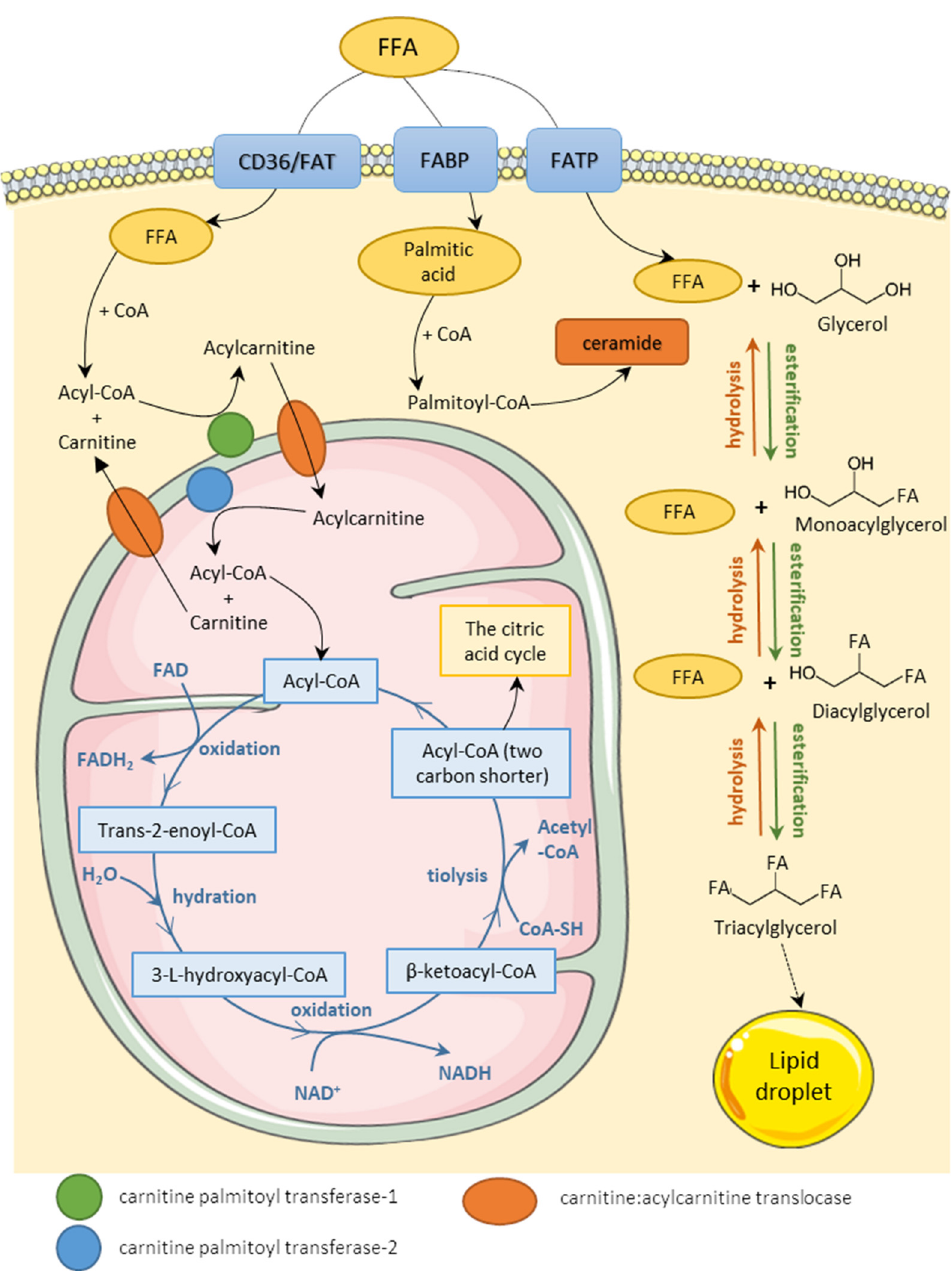
Figure 1. Homeostasis and metabolism of free fatty acids. FFAs circulating in the blood serum are bound to albumin. After the release from the albumin complex, FFAs are transported through the cell membrane by three various transporters: CD36/FAT, FABP, or FATP. Once in the cytoplasm, FFAs undergo esterification to TAG, which may be hydrolyzed to DAG. TAG is stored in lipid droplets. Lipid droplet is surrounded by proteins called perilipins, which regulate TAG exposition to hydrolytic enzymes. FFA may also be activated to acyl-CoA via the reaction with CoA. Palmitic acid is activated to palmitoyl-CoA, which is a substrate to de novo ceramide synthesis. Acyl-CoA is transported via the outer mitochondrial membrane by CPT-1, which also catalyzes acyl-CoA’s reaction with L-carnitine to create acyl-carnitine. The form of acyl-carnitine is necessary for the transport